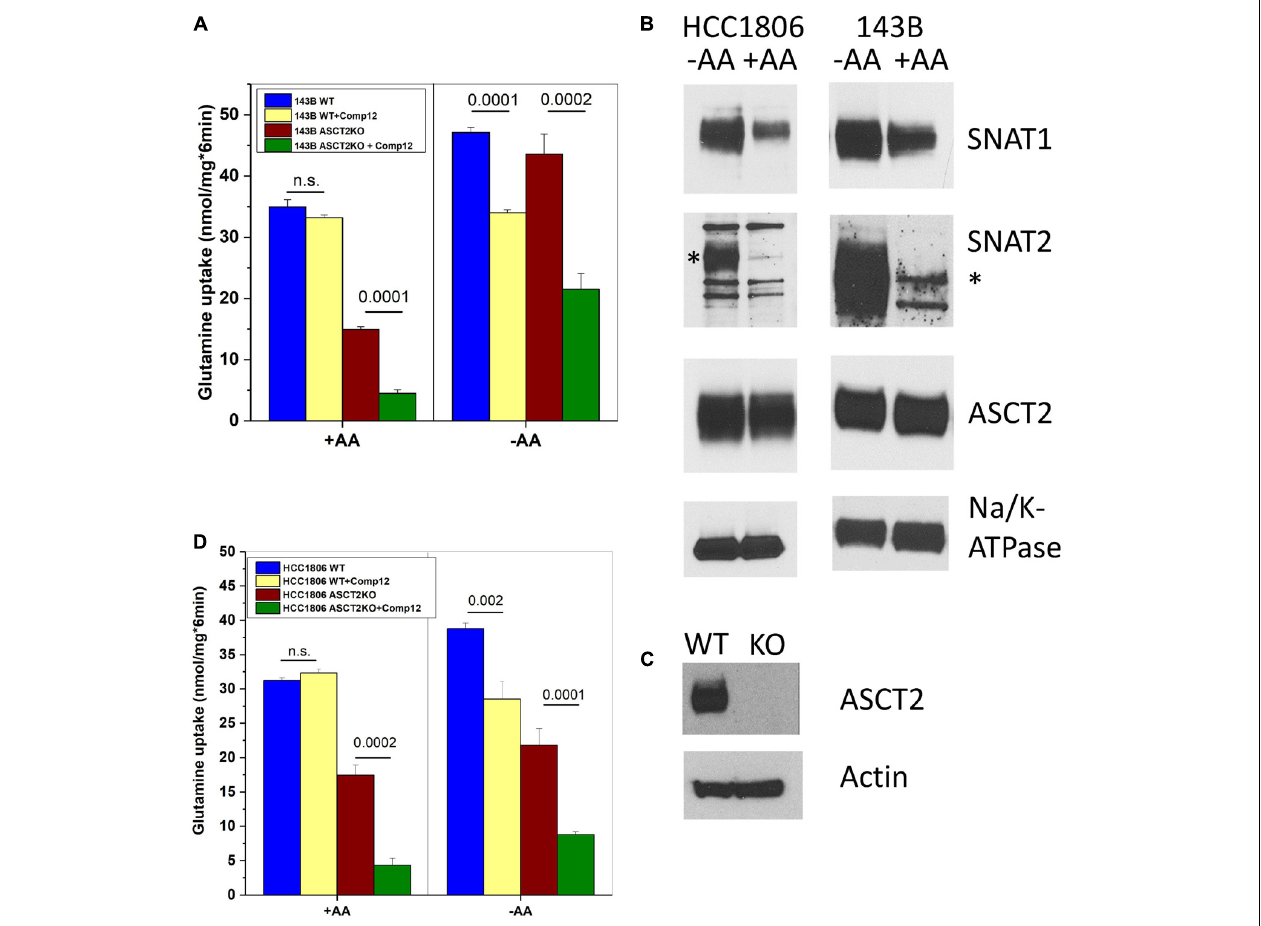
FIGURE 2 | Inhibition of glutamine transport by AABA in wild-type and ASCT2ko cells. (A) Uptake of [ 14 C]glutamine (100 µ M) was measured in 143B cells [parental (wt) and ASCT2ko] in the presence or absence of 100 µ M compound 12. Before transport, cells were kept in DMEM/F12 medium supplemented with 10% FCS (+AA) or in Hank’s buffered salts solution supplemented with 5-mM glucose and 1% dialyzed FCS (–AA) for 12 h [parental (wt) n = 5 and ASCT2ko n = 9 for each condition]. p -Values are indicated in the figure. (B) 143B cells and HCC1806 cells were incubated as in A and used for surface biotinylation and subsequent detection of glutamine transporters by immunoblotting. Na + , K + -ATPase was used as a loading control; the SNAT2-specific band is indicated by an asterisk (*) ( n = 3). (C) Detection of ASCT2 in cell homogenates of parental and genome edited HCC1806 triple-negative breast cancer cells. Actin was used as a loading control ( n = 5). (D) Uptake of [ 14 C]glutamine (100 µ M) was measured in HCC1806 cells [parental (wt) and ASCT2ko] in the presence or absence of 100 µ M compound 12. Before transport, cells were kept in DMEM/F12 medium supplemented with 10% FCS (+AA) or in Hank’s buffered salts solution supplemented with 5-mM glucose and 1% dialyzed FCS (–AA) for 12 h (parental n = 5 and ASCT2ko n = 5 for each condition). p -Values are indicated in the